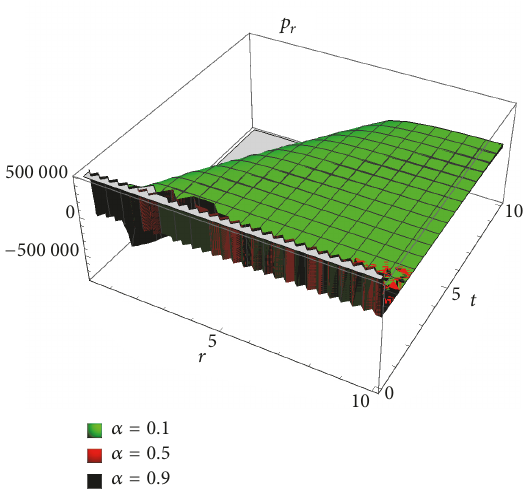
Figure 10: Mass behavior along 𝑟 and 𝑡 for 𝑟 0 = 0.5 and the different values of 𝛼